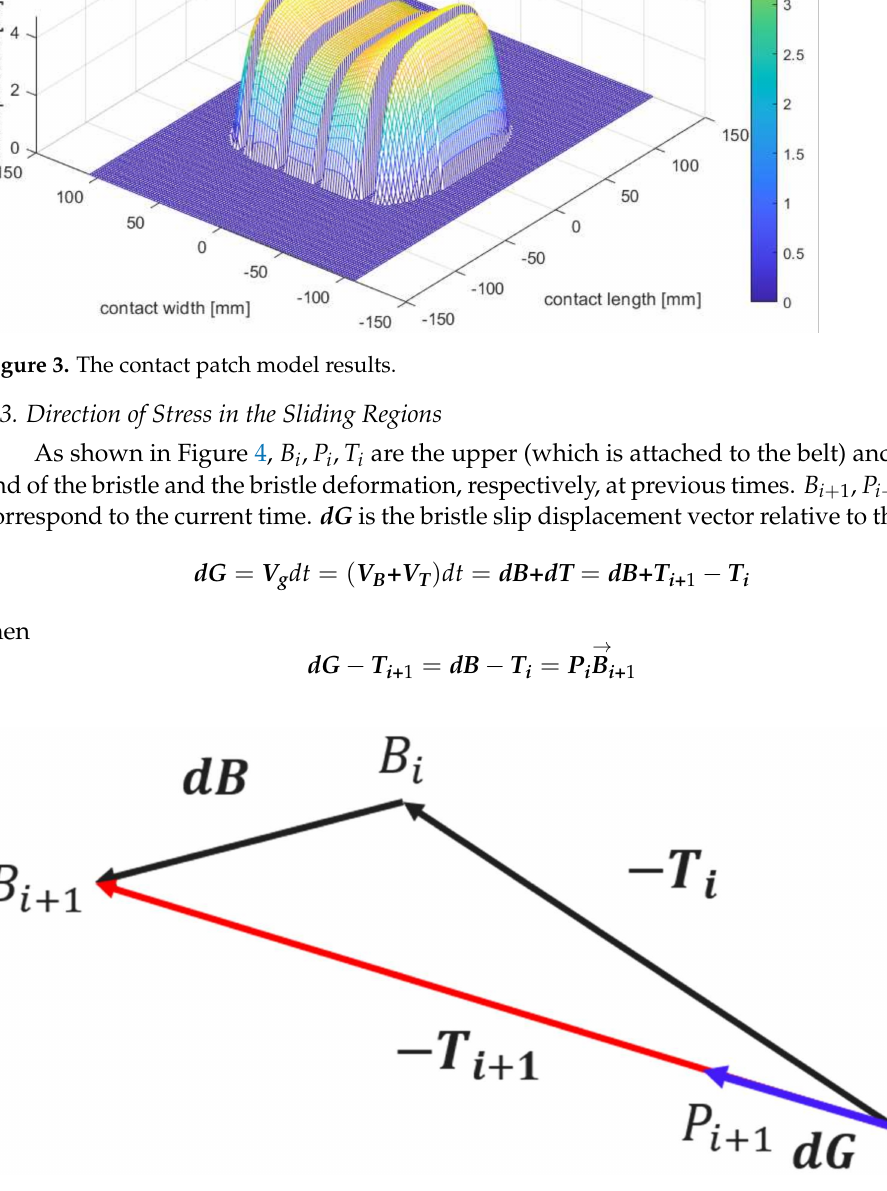
Figure 4. Tread element deformation and its slip displacement vector relative to the